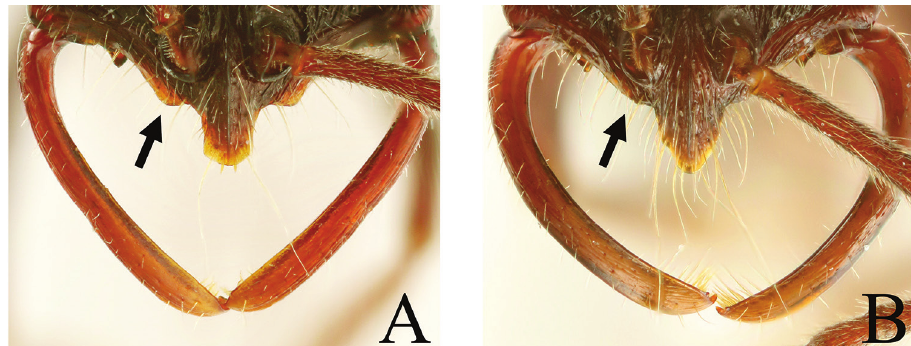
Figure 17. Clypeus and mandible, full-face view. A L. itoi B L. kanaoi